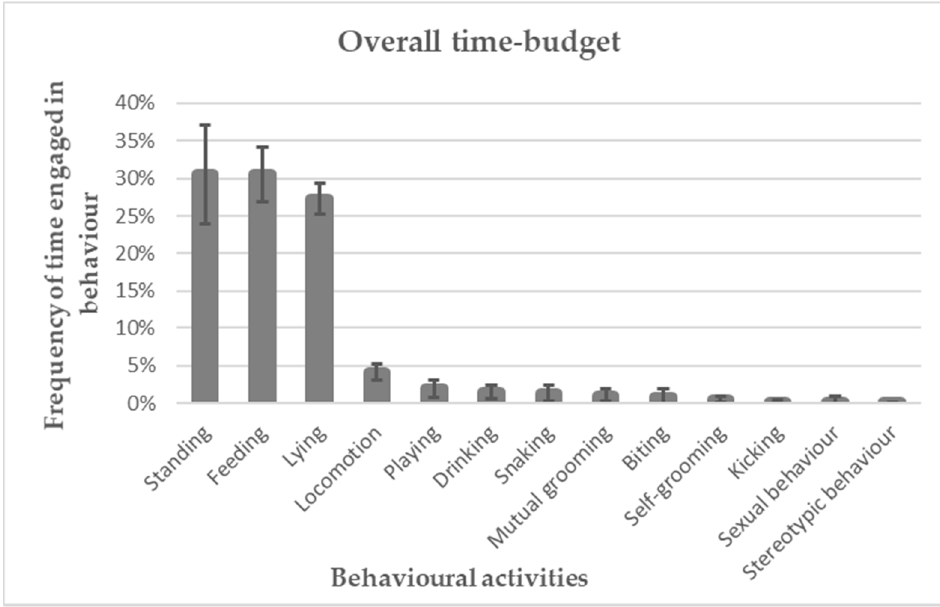
Figure 1. Frequency of time (%) spent by horses in behavioural activities.